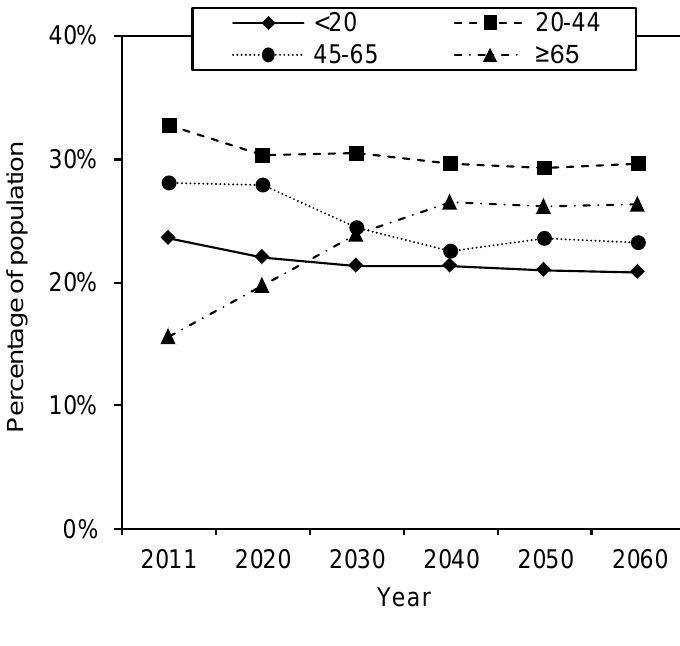
Figure 1. Demographic buildup in four age groups of the Dutch population between 2011 and 2060 according to counts (for 2011) and predictions (from 2020 onwards) by Statistics Netherlands